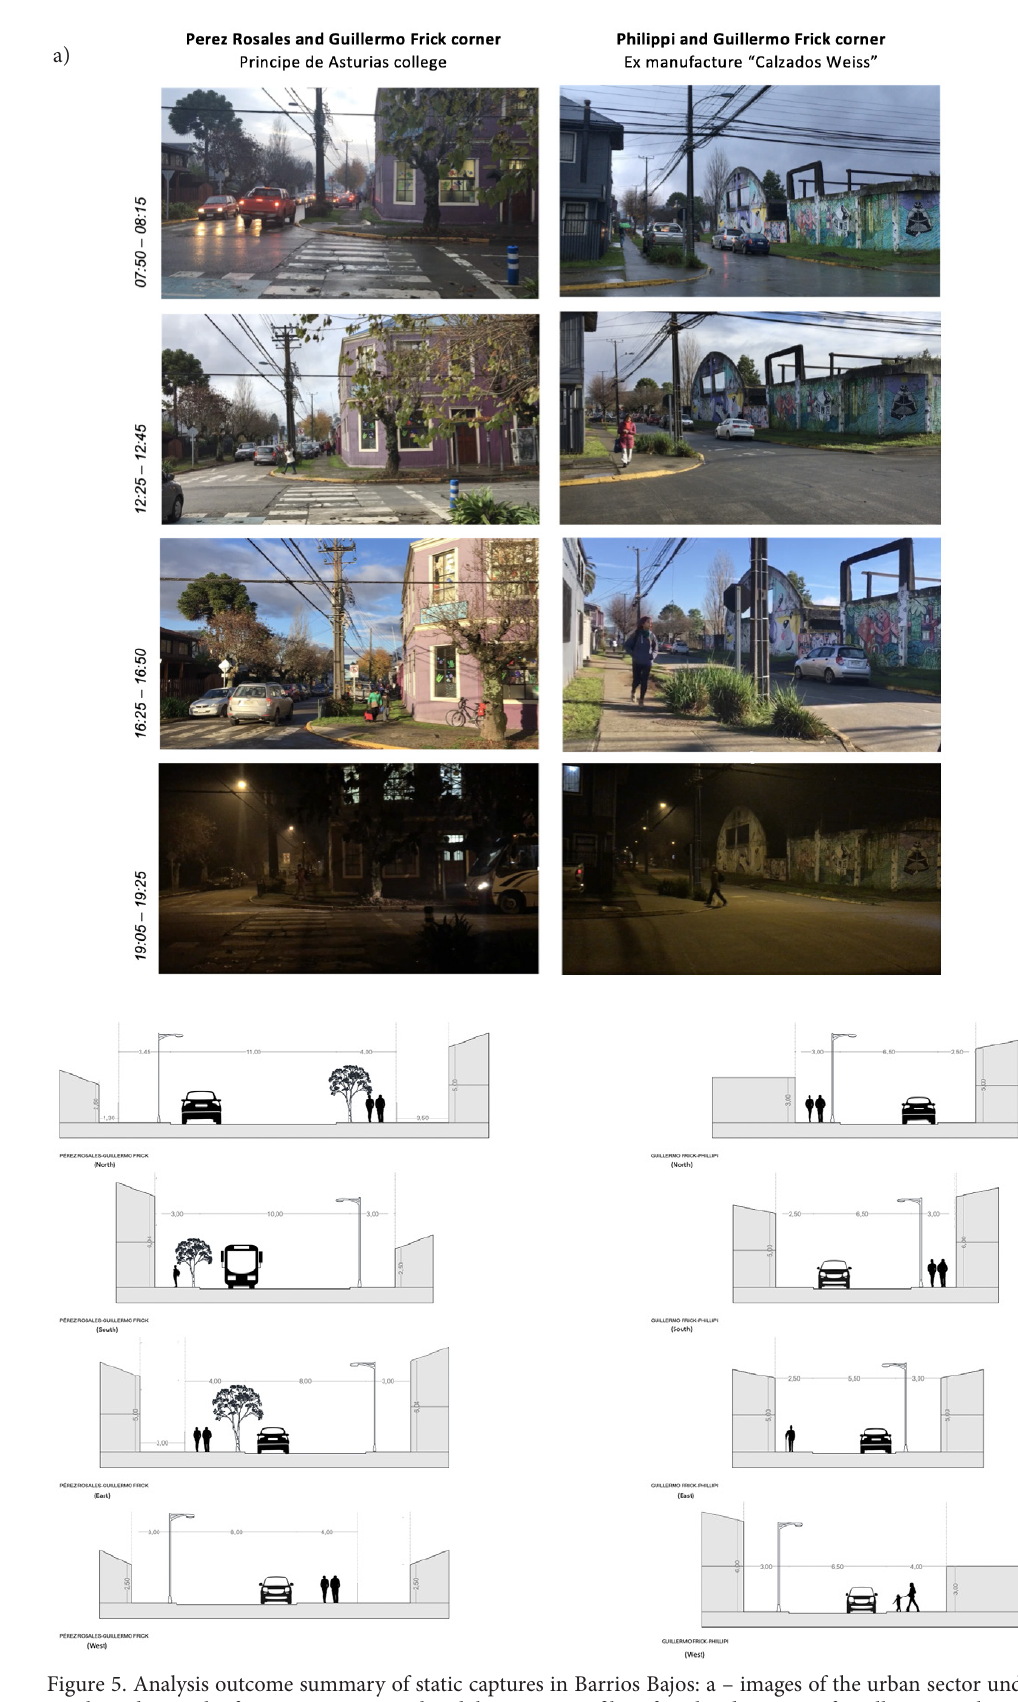
Figure 5. Analysis outcome summary of static captures in Barrios Bajos: a – images of the urban sector under analysis during the four moments considered; b – street profiles of analized corners of Guillermo Frick with Perez Rosales and